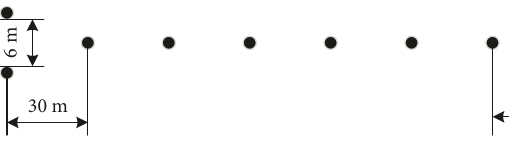
Figure 21: Overview of snake testing.